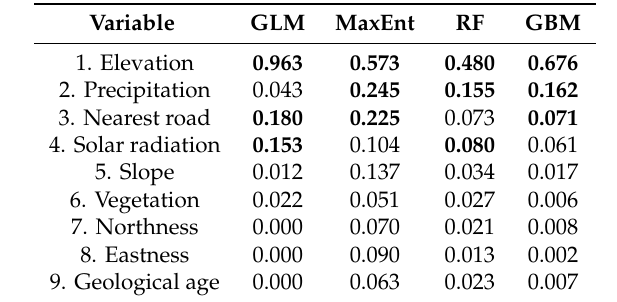
Table 2. Variable importance for the single model algorithms (GLM, MaxEnt, RF, and GBM) of the ensemble modeling approach. The three most important variables for each model are written in bold. Variables are ranked from highest (1.) to lowest (9.) importance.